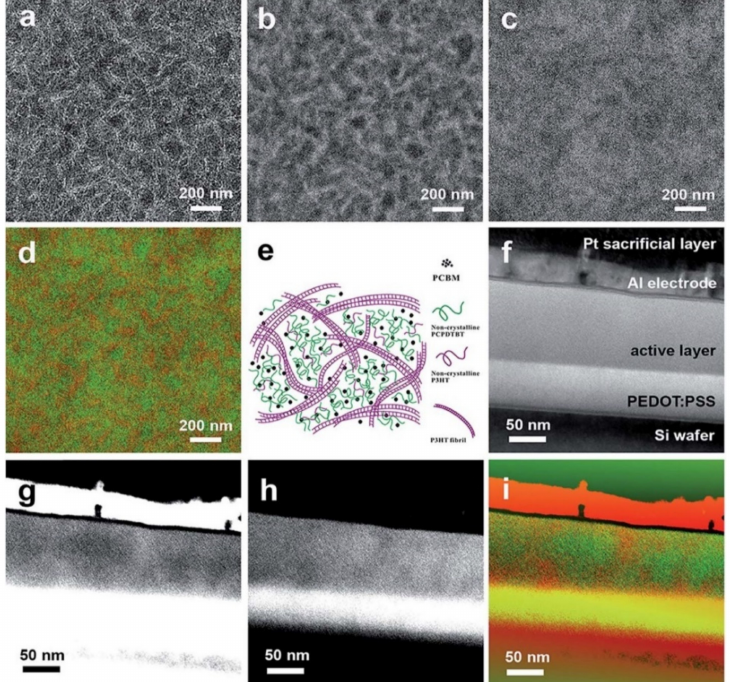
Figure 15. EF-TEM ( a ) 0 ± 4 eV, ( b ) 19 ± 4 eV, and ( c ) 30 ± 4 eV images, ( d ) color mix map for lateral section of pre-annealed ternary blend thin films of P3HT-32k:PCPDTBT:PCBM with a weight ratio of 3:1:4 (25 wt% of PCPDTBT), and the corresponding scheme ( e ). EF-TEM [49] ( f ) 0 ± 4 eV, ( g ) 19 ± 4 eV, and ( h ) 30 ± 4 eV images, and ( i ) color mix map for cross-section of post-annealed ternary blend thin films of P3HT-32k:PCPDTBT:PCBM with a weight ratio of 3:1:4. Reproduced from [49] with permission from the Royal Society of